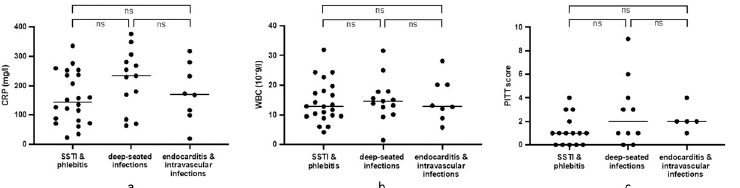
Fig 2. C-reactive protein (CRP) per iection category (A); white blood cell count (WBC) per infection category (B); Pitt bacteremia score per infection category (C). SSTI = skin and soft tissue infections; BDL = bacterial DNA load; ns = non-significant